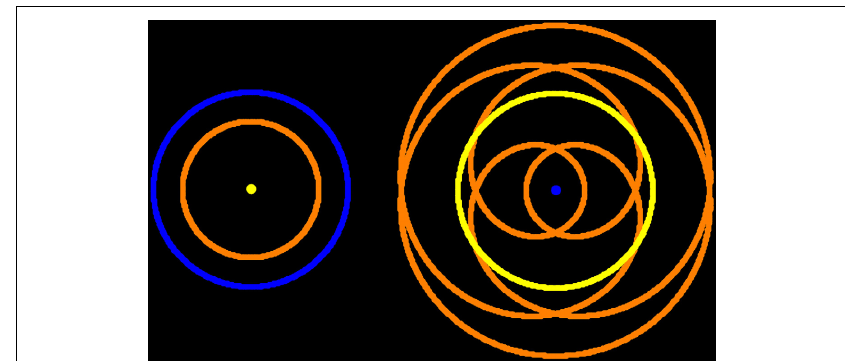
FIGURE 1 | Simplistic schematic of the heliocentric model (left) and the geocentric model (right). The motion of the Sun (yellow) and the planets Earth (blue) and Venus (orange) is shown. Under the heliocentric model both Earth and Venus have simple circular orbits around the Sun. In contrast, under the geocentric model Venus describes a complicated (albeit beautiful) path. The heliocentric model is by far the more parsimonious explanation for our observation of the motions of celestial bodies, especially when taking Newtonian physics into account. It is important to note that this heliocentric model is not the “true” model as for instance the orbits are not circular and the planets do not strictly revolve around the center of the sun. However, it is certainly the better model of the two as it requires fewer